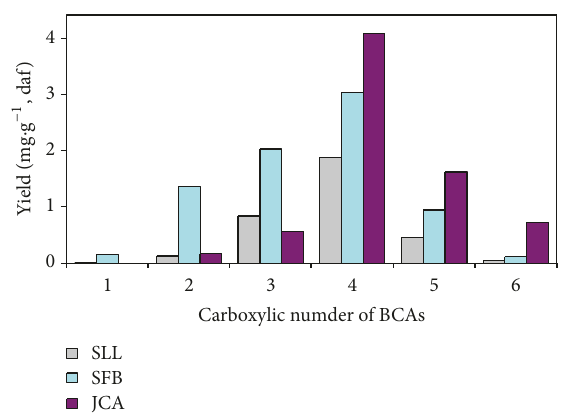
Figure 3: Distribution of BCAs from coal oxidation.